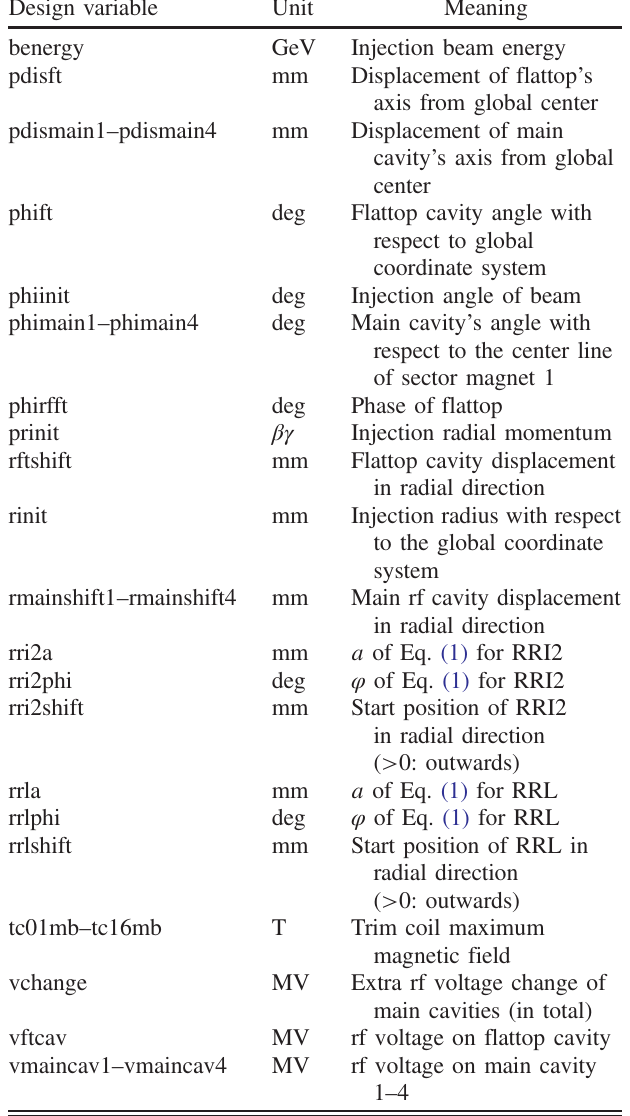
TABLE V. Design variable abbreviations and their